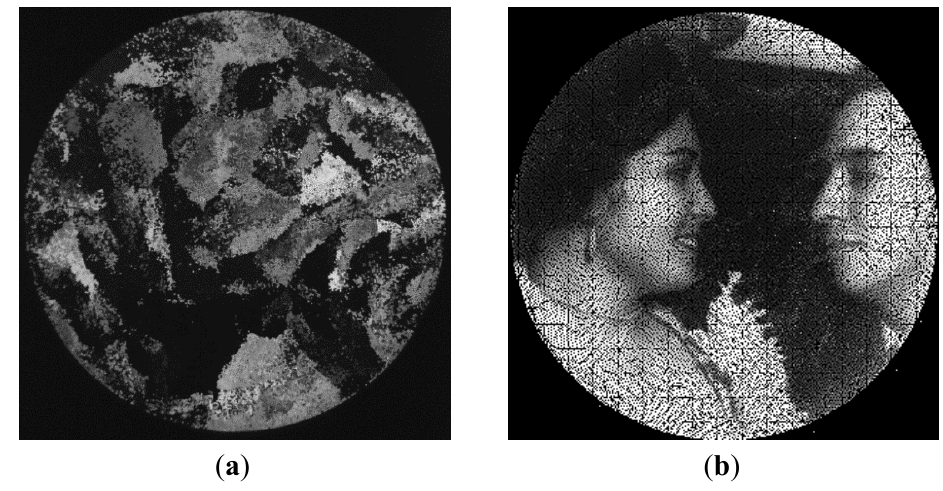
Figure 2. An example of an image captured by the sensor ( a ) cluttered image Id ( b ) primitive image Ip obtained through RT